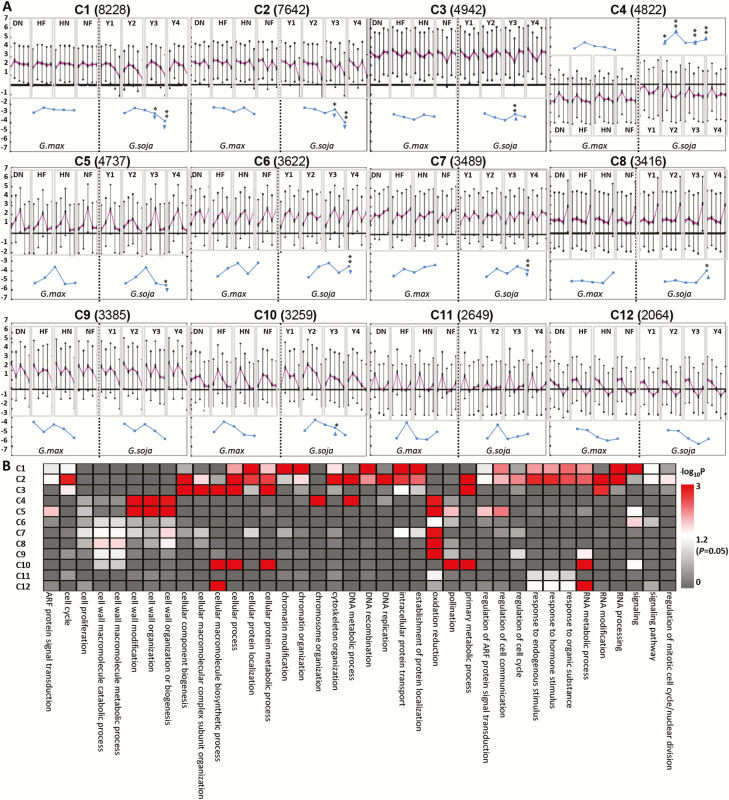
Gene expression pattern between wild and cultivated soybeans. (A) Gene clusters identified in 40 samples. Twelve gene clusters (C1–C12) were identified using k-means clustering. In each cluster, the y-axis represents log2 FPKM derived from RNA-seq data for each biological sample, while the x-axis represents the biological samples that are ordered as JJ, WH, H, G5, and G15 for each accession as indicated by DN, HF, HN, NF, Y1, Y2, Y3, and Y4, respectively. The blue curve represents the average expression of genes in each tissue of four accessions for both G. max and G. soja. Statistical differences (*P<0.05, **P<0.01) are indicated by Student’s t-test. The inverted triangles indicate down-regulation, and the upright triangles indicate up-regulation. (B) Heatmap of –log10P of biological process category enrichment by AgriGO among the 12 clusters.